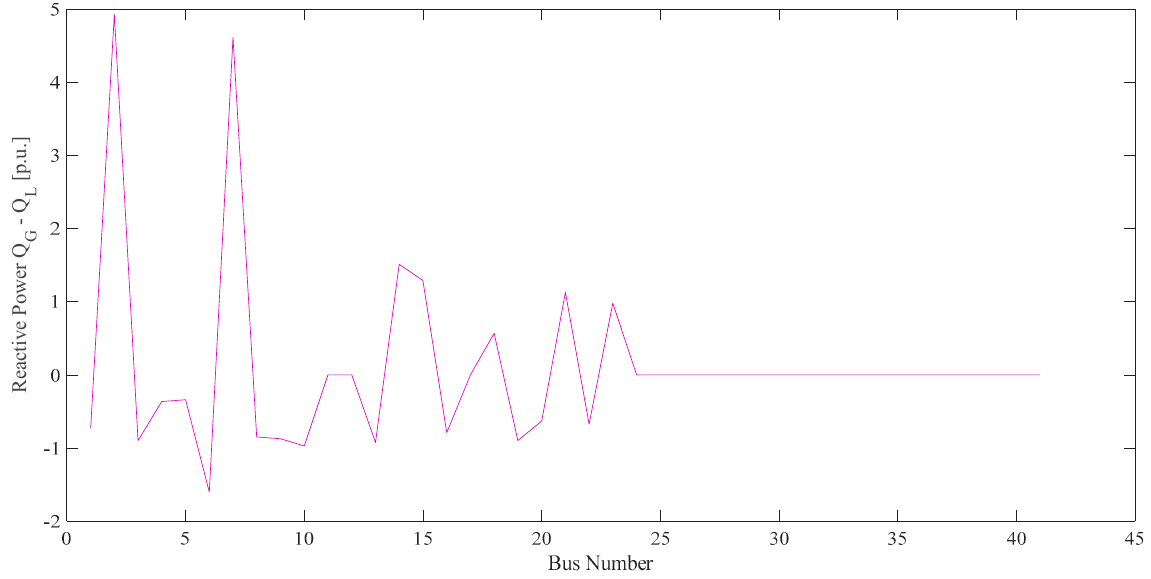
Figure 5. Real power output of the uncompensated Nigerian 41 bus transmission network.